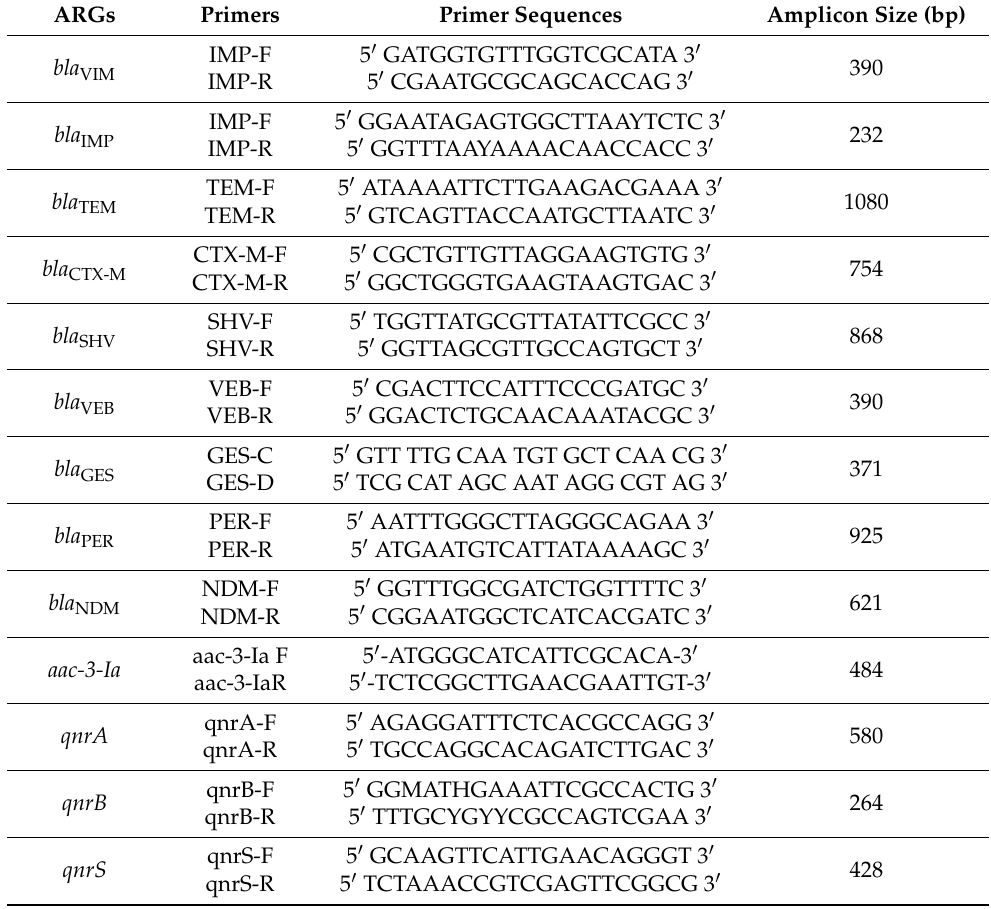
Table 4. Primers for the detection of antibiotic resistance